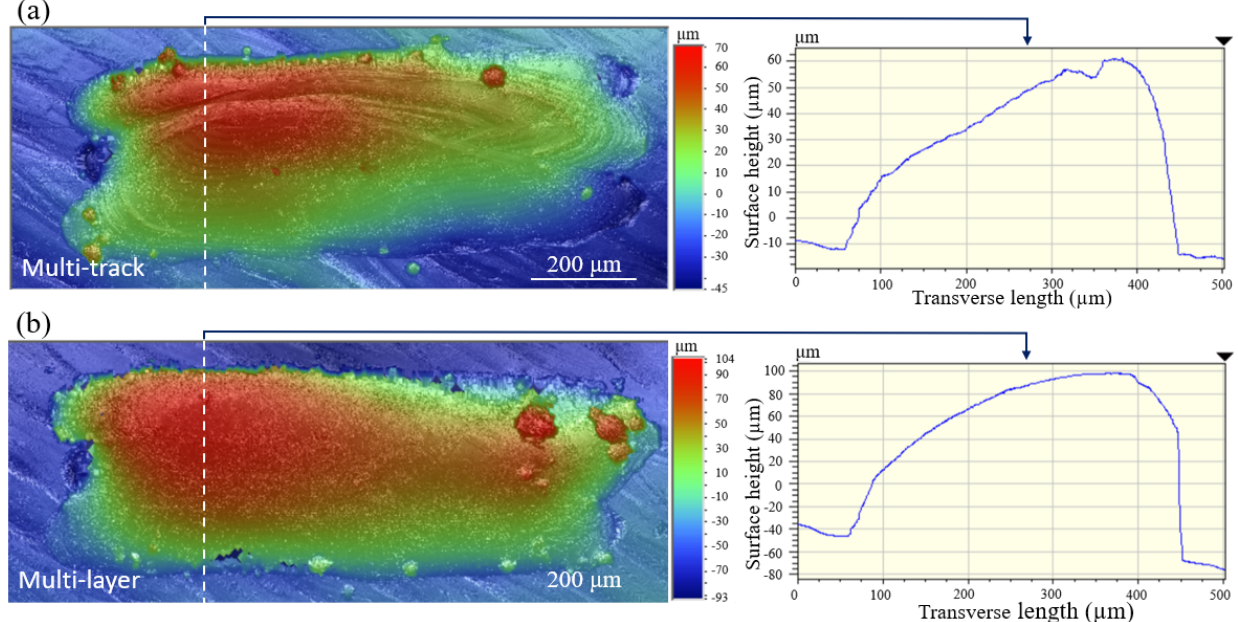
Figure 8. Surface morphology obtained from ( a ) multi − track, single layer, and ( b ) multi − track, multi-layer samples (195 W, 750 mm/s and 120 µm).